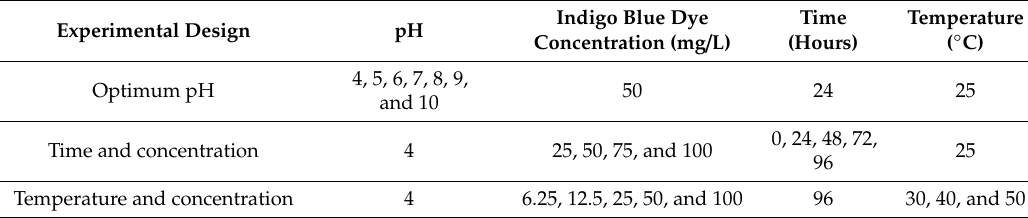
Table 1. Experimental conditions for experimental designs. The pH was fixed at 4 after optimum pH test. The concentration of S. platensis was of 1 g / L for all